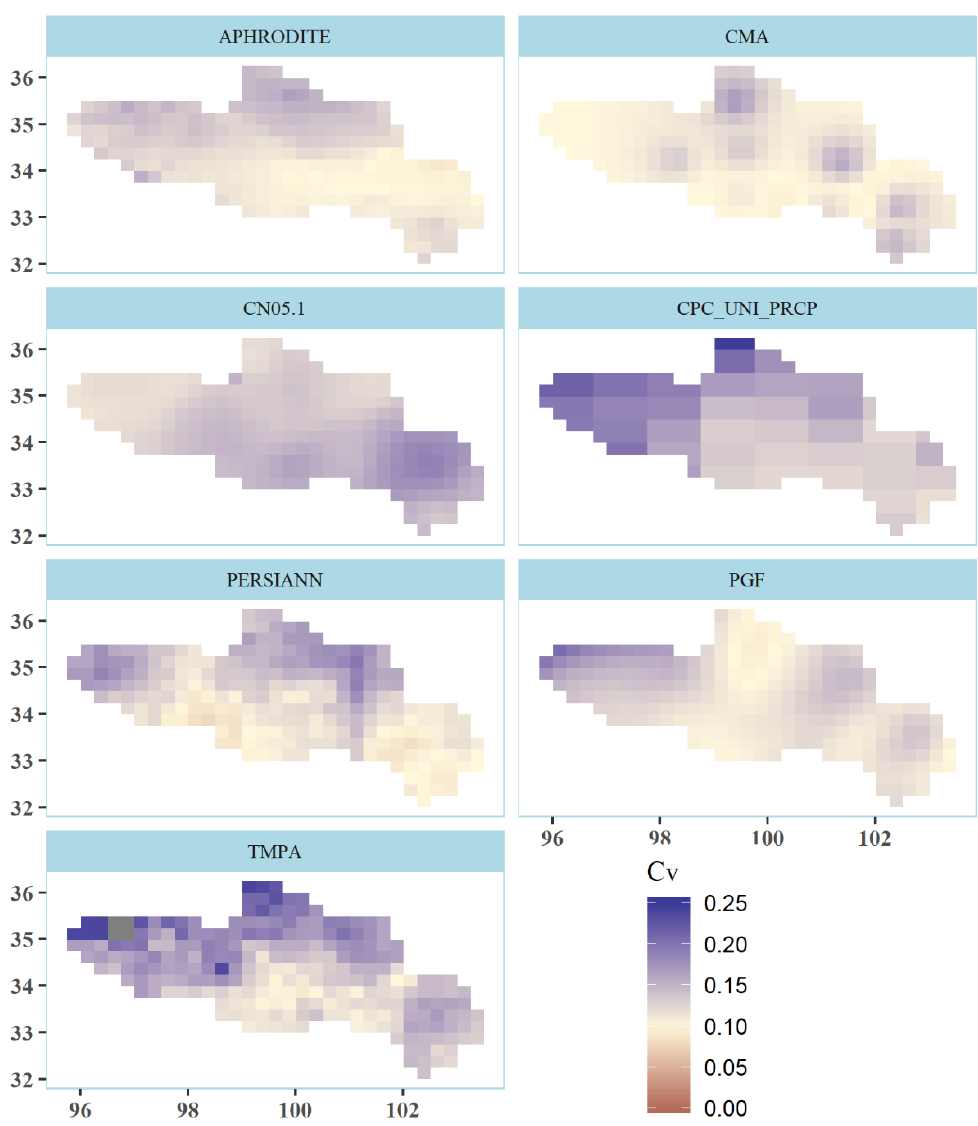
Figure 3. Spatial distribution of variation coefficients (C V ) of annual precipitation estimates in the period 1998–2014 from CMA gauge-based estimates and 6 other SDFE or RA precipitation estimate products, where Cv is the ratio between standard deviation and mean value.